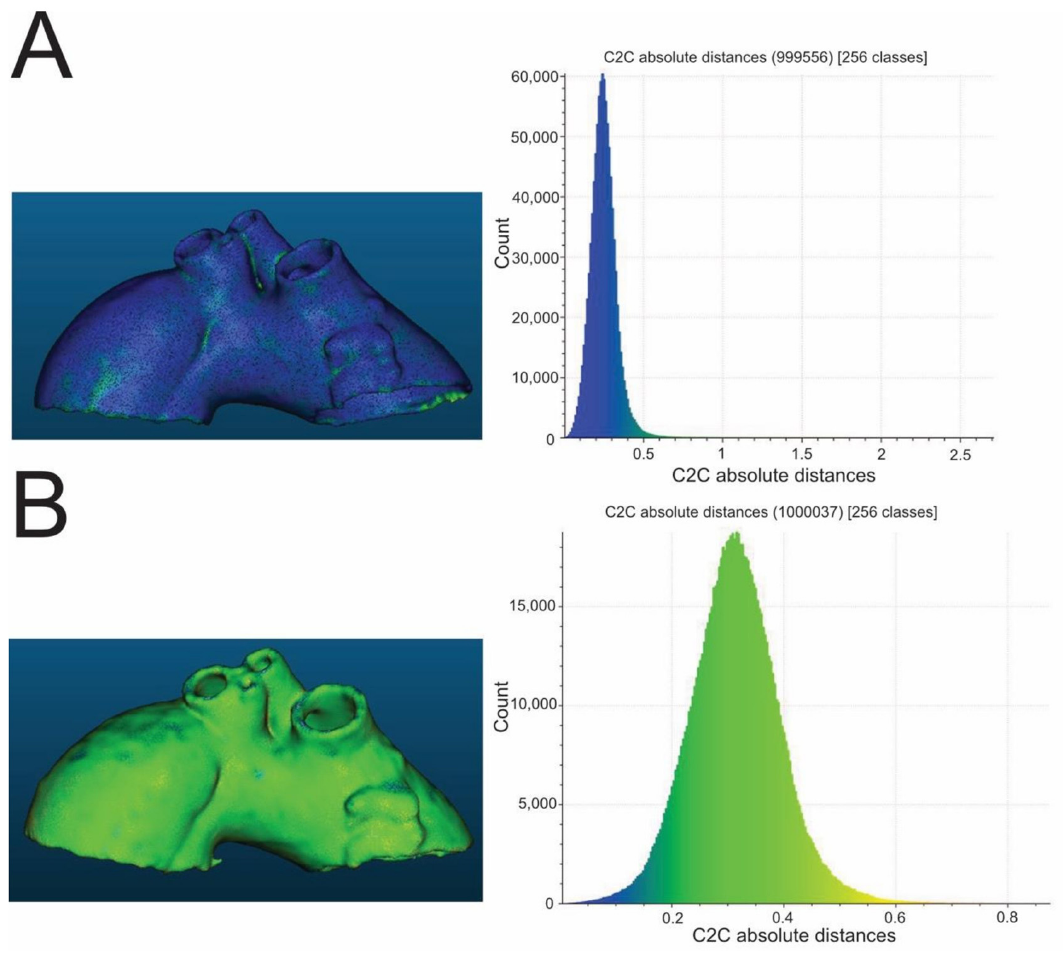
Figure 2. Exemplary color-coded differences (mm) between pre- and post-sterilization aortic tem- plates and corresponding histograms. The presented aortic templates were made of PLA ( A ), PETG ( B ), and nylon ( C ). All were sterilized in a 105 ◦ C autoclave. PLA—polylactic acid; PETG— polyethylene terephthalate